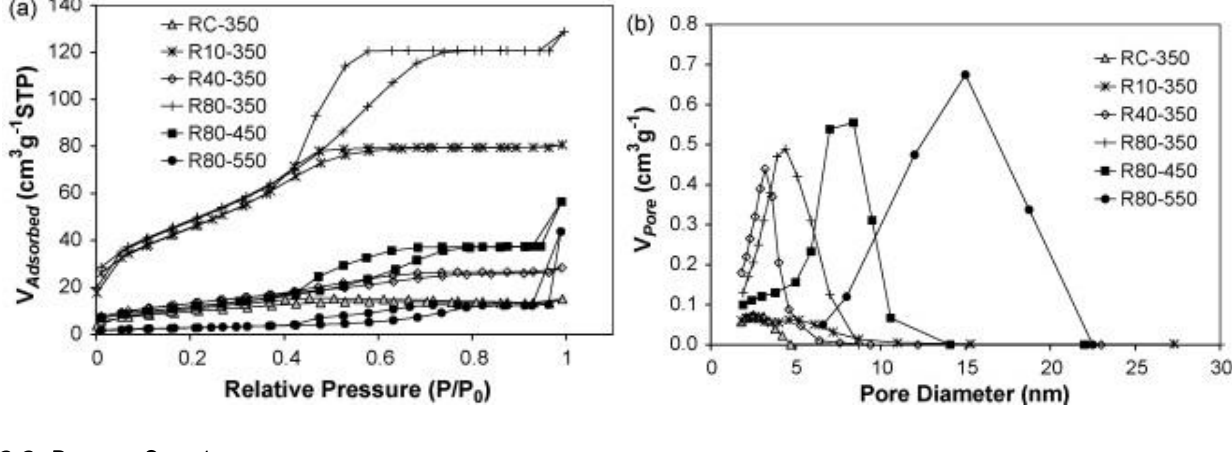
Figure 12. Nitrogen isotherms of mesoporous titania films ( a ) effect of calcination temperatures; and ( b ) corresponding pore-size-distribution plots. Reprinted with permission from [77]. 2009